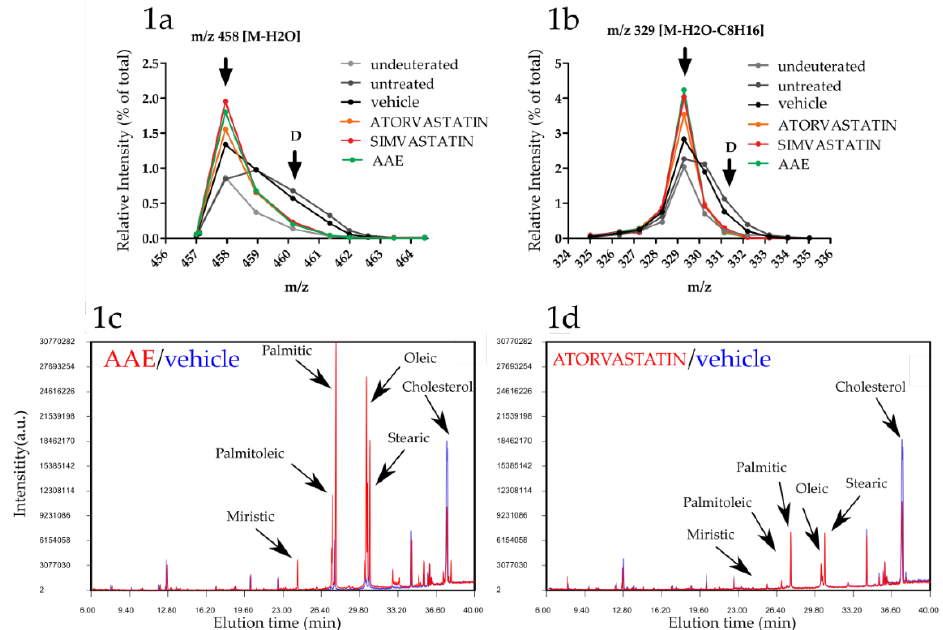
Figure 1. AAE inhibits cholesterogenesis in HuH7 cells. HuH7 cells were grown in the presence of D 2 O and treated for 72 h in the presence of Atorvastatin (Orange dots and lines), Simvastatin (Red), Annurca polyphenolic extract (AAE (green) or the corresponding volume of vehicle (DMSO, black) or water (untreated, dark gray). HuH7 were as well grown in the absence of D 2 O (undeuterated, light gray) or left untreated for comparison. ( a , b ) MS analysis of GC peaks eluting at 37.5 min and containing undeuterated TMS derivatized cholesterol (m/z 458 M-H20), a cholesterol fragment (m/z 329 M-H20 -C8H16) and their corresponding deuterated forms (arrows labeled with the letter D). ( c , d ) Comparison of gas chromatography-mass spectrometry (GC/MS) spectra (intensity versus retention time) of samples extracted from HuH7 cells treated with AAE ( c , red profile), vehicle ( c , d , blue profile) or Atorvastatin ( d , red profile). Arrows indicate cholesterol and fatty acid (FA) over-represented in AAE treated samples. (Representative of at least three experiments).